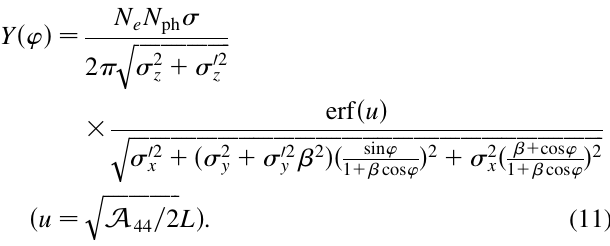
FIG. 2. Dependencies of Y (cid:2) ’ (cid:3) =Y (cid:2) 0 (cid:3) on ’ at various (cid:31)